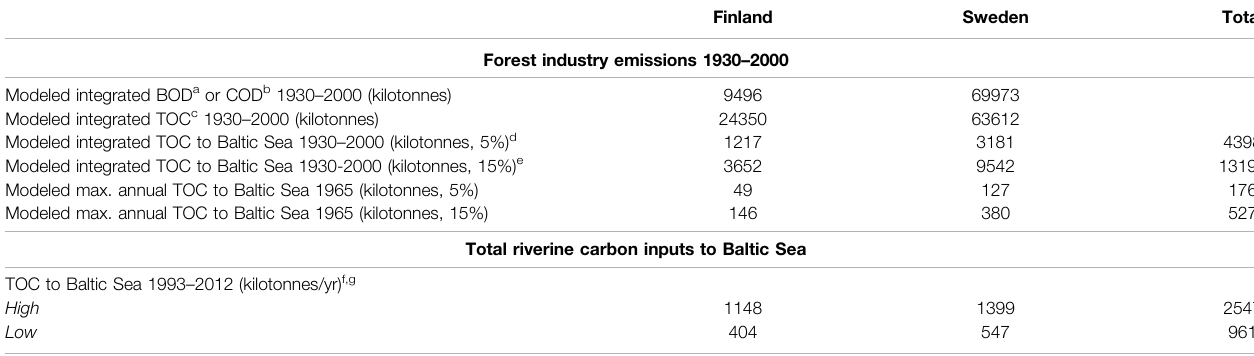
TABLE 4 | Estimate of total carbon emissions to the Baltic Sea from forest industry point sources in Finland and Sweden during 1930 –